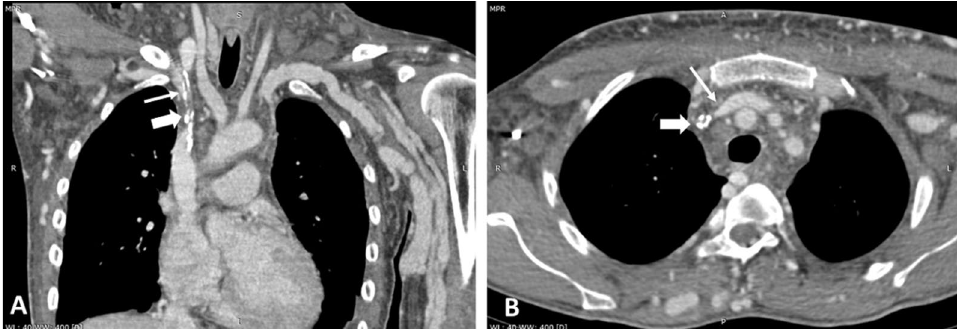
Fig. 2 Contrasted delayed-phase CT venogram in coronal and axial view showing stenosis and non-opacification of bilateral brachiocephalic veins (thin white arrows) near the confluence extending to the upper SVC. The retained calcified sheath (thick white arrows) showed no contrast opacification within